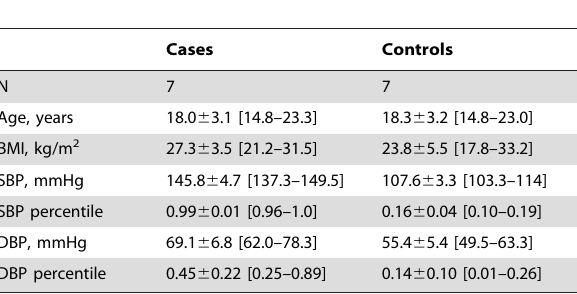
Table 1. General characteristics of cases and controls for genome-wide methylation